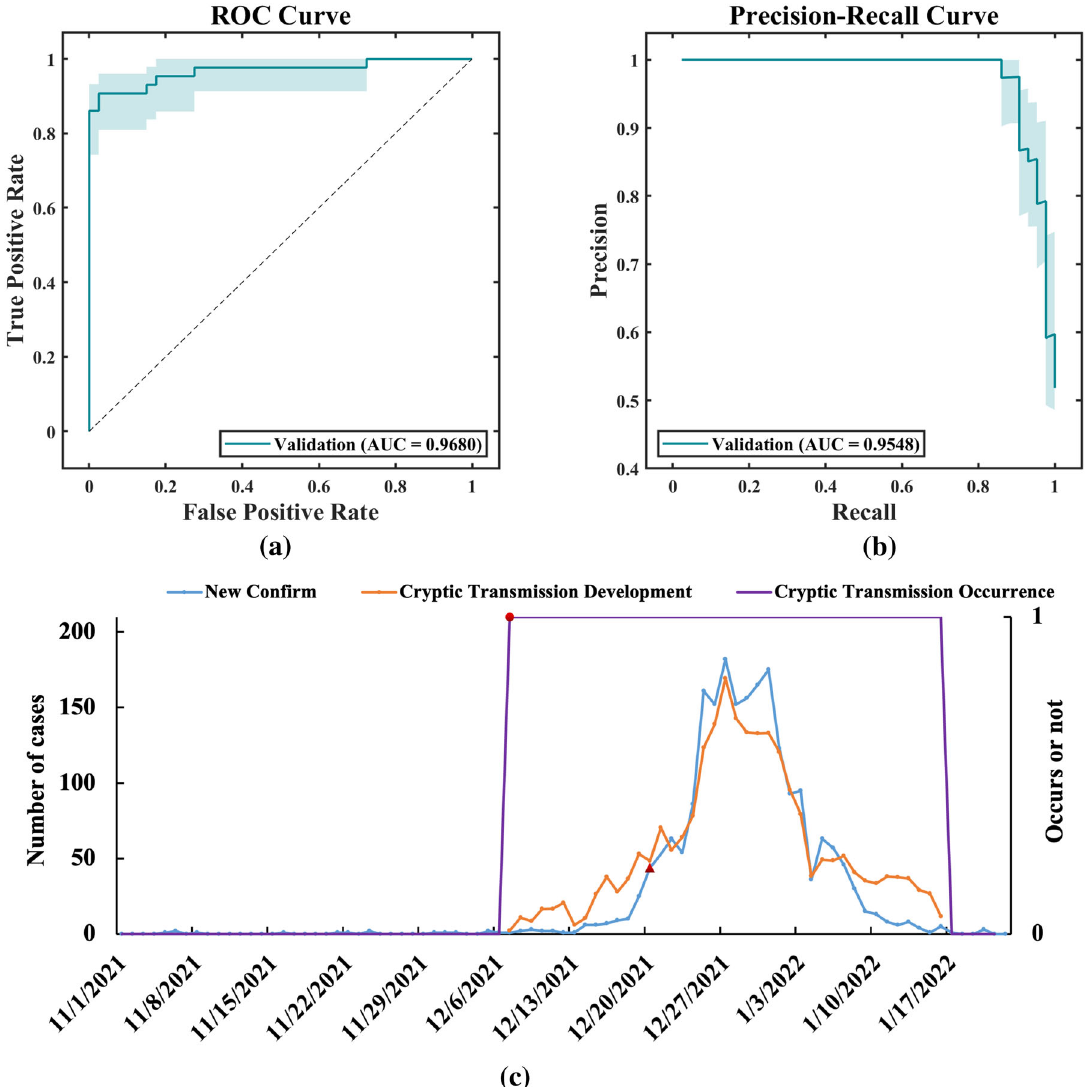
Fig. 7 Occurrence, development, and fi tting of the external validation data. a The ROC curves of early warning; b the PR curves of early warning; c the fi tting curve of the occurrence and development of the epidemic. The blue line represents the actual number of con fi rmed cases per day, the purple line represents the predicted occurrence result of the model, the orange line represents the predicted development result of the model, the triangular icon represents the time point of the of fi cial report of cryptic transmission, the circular icon represents the time point of our prediction of the occurrence of cryptic transmission, and our prediction time is 13 days ahead of the of fi cial